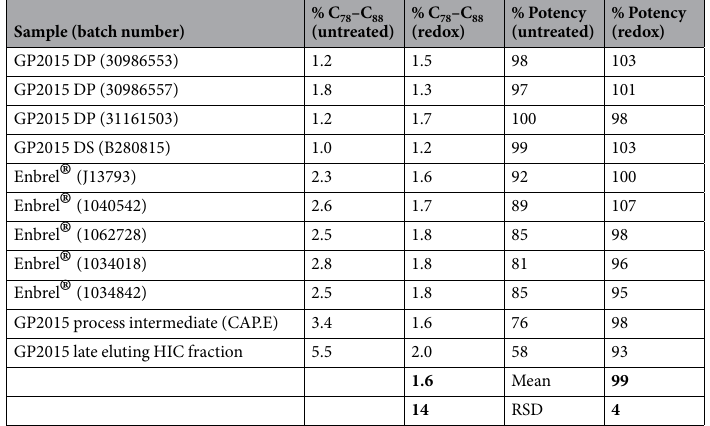
Table 2. The impact of serum-like redox conditions on incorrect disulfide bridging and potency. The degree of potency and the relative amount of C 78 -C 88 , as determined by non reducing peptide map analysis, was assessed in selected GP2015 (Erelzi ® ) and Enbrel ® reference product samples before and after exposure to serum-like redox conditions (see methods section for details). Following exposure, a concomitant elimination of incorrect